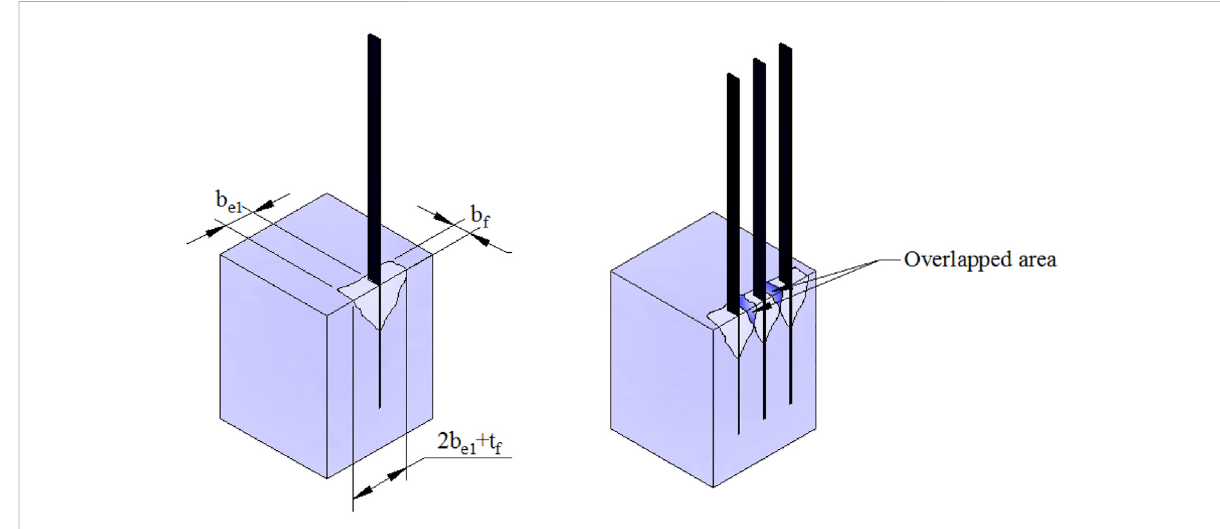
FIGURE 12 Failure mode of one and three NSM strips (After Seo et al.,